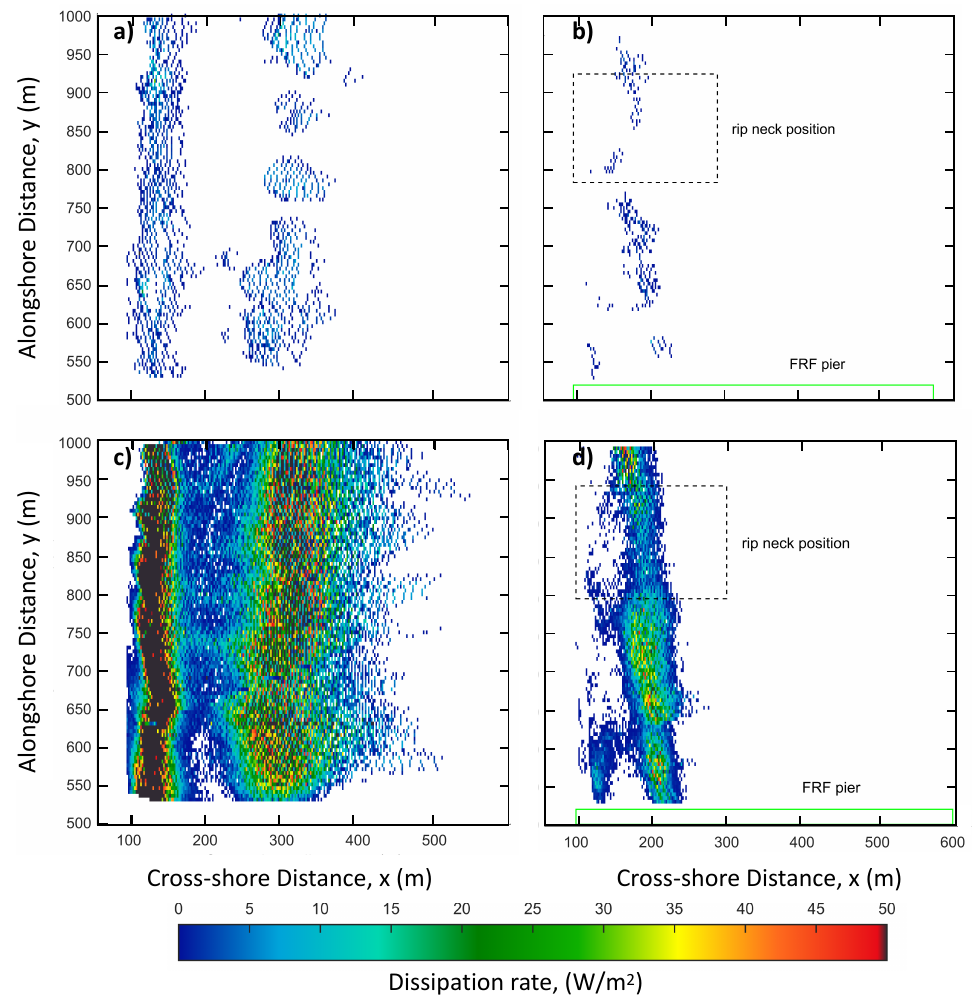
Figure 7. Wave breaking energy dissipation rate maps averaged over 1 T p ( top ) and 100 T p ( bottom ). R1 ( left ) and R2 ( right